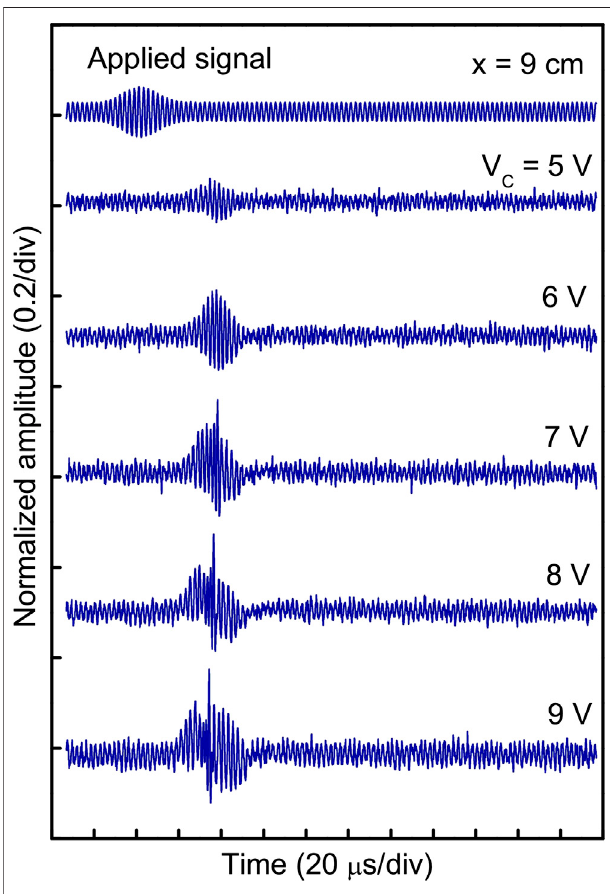
FIGURE5 | Typical examplesexperimentally observedPeregrine soliton at x (cid:2) 9 cm from the grid. The top trace is the applied signal with carrier and modulation frequencies 380 and 30 kHz,